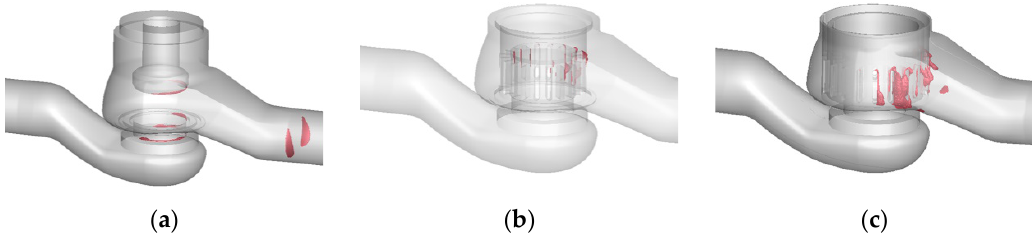
Figure 5. Water vapor volume distribution for globe valve with a different number of cages: ( a ) no cage; ( b ) 1 cage; ( c ) 2 cages.